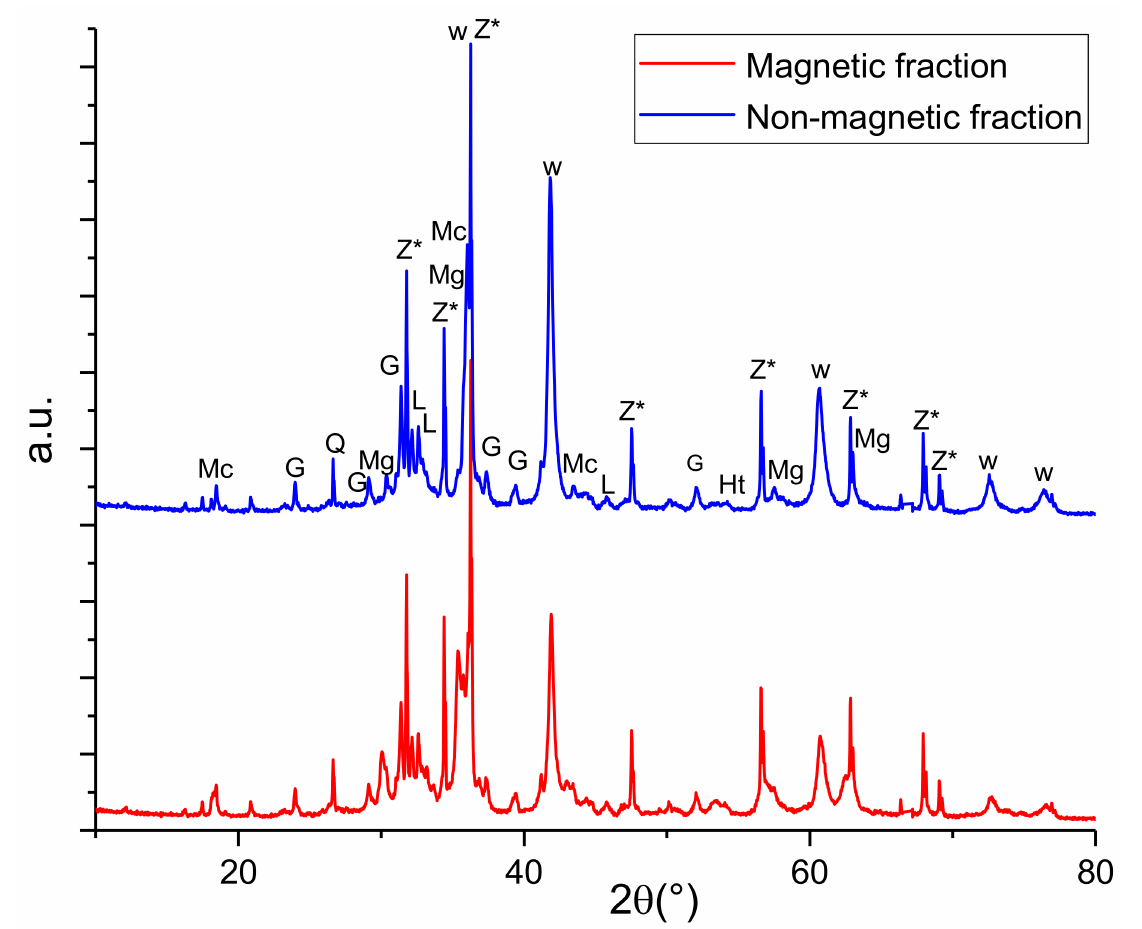
Figure 3. Mineral phases contained in the magnetic and non-magnetic fractions of the size fraction +0.25–1 mm [Mc: Magnesio-chromite, G: Gehlenite, Q: Quartz, Mg: Magnetite, L: Larnite, W: Wüstite, Ht: Hematite and Z*: added zinc oxide] (arbitrary unit for the ordinates).